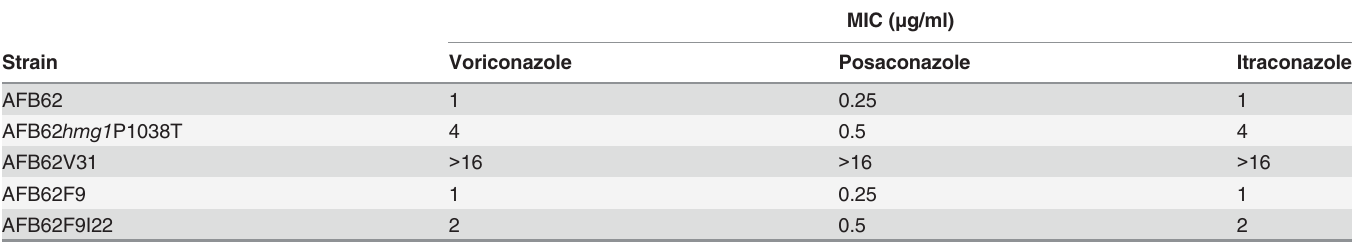
Table 3. Azole resistance in spontaneous and engineered